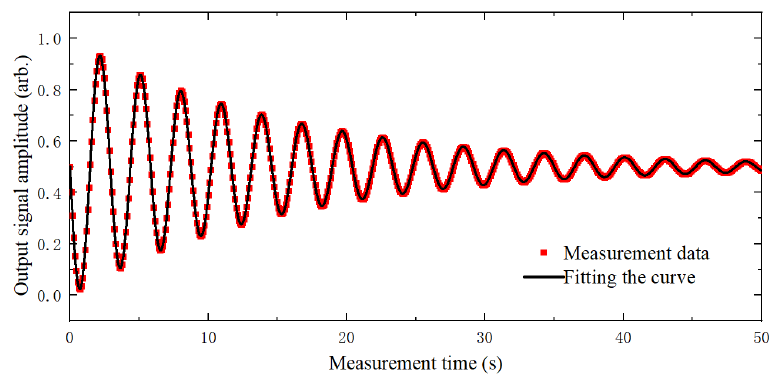
Figure 5. Experimental measurement of transverse relaxation rate of inert atoms in strongly coupled spin ensemble without magnetic field gradient.